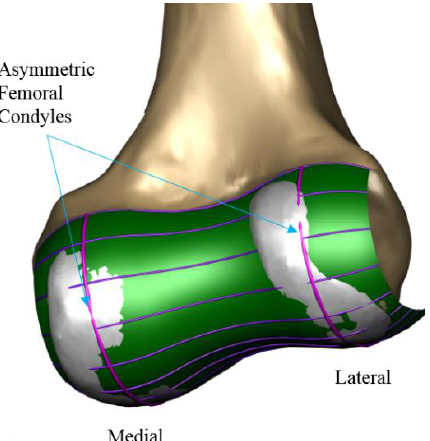
Figure 1. Patient-specific three-dimensional (3D) model design with actual anatomical geometries.